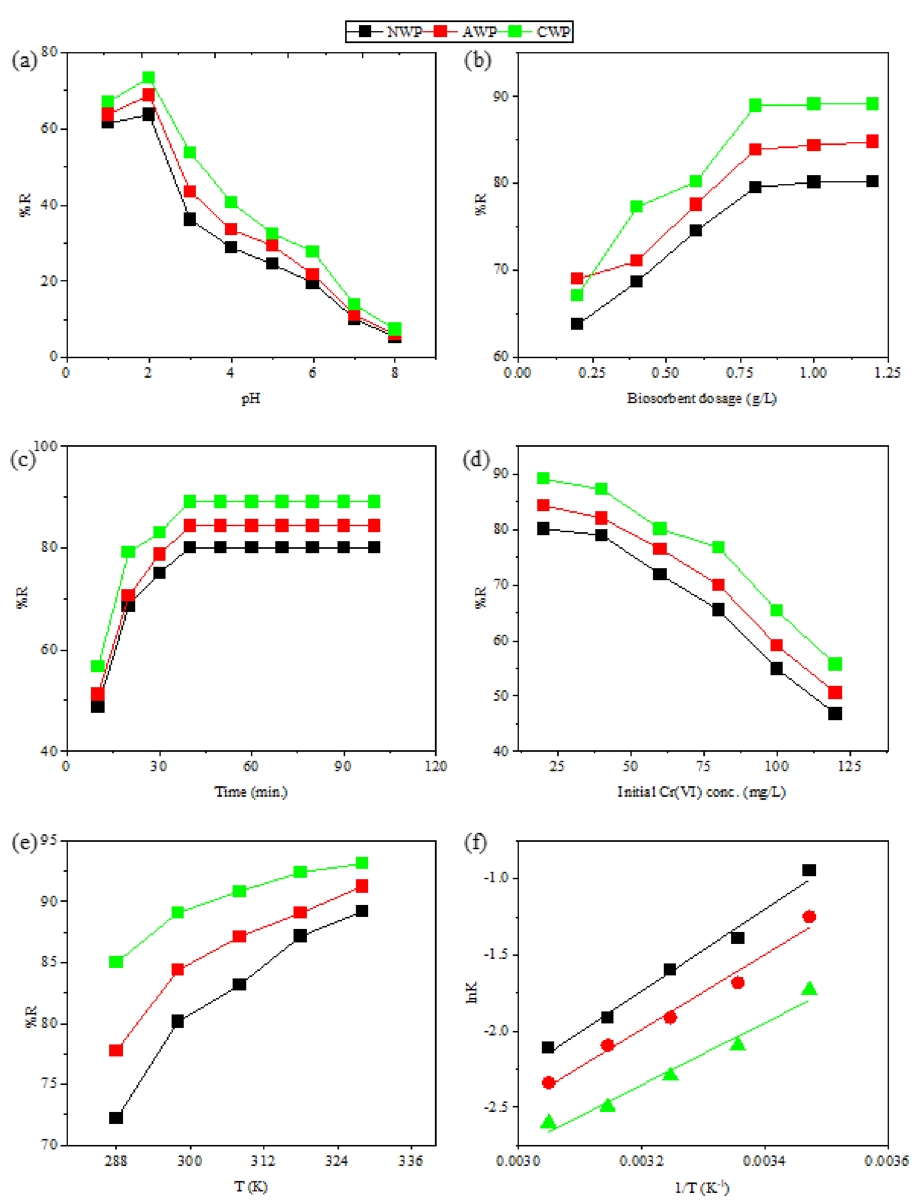
Figure 4. Effect of ( a ) pH ( b ) biosorbent dosage ( c ) contact time ( d ) initial concentration of Cr(VI) ( e ) temperature variation and ( f ) Van’t Hoff plots for adsorption of